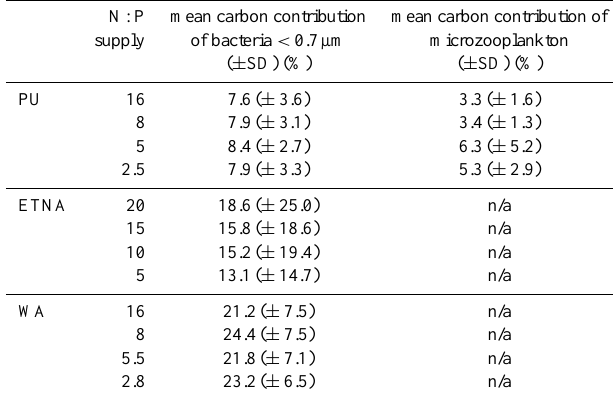
Table 3. Mean contribution of heterotrophic bacteria ( < 0.7µm) and microzooplankton (ciliates) to the organic carbon pool over time for each of the three experiments. No data of microzooplankton are available for the ETNA and WA experiment.